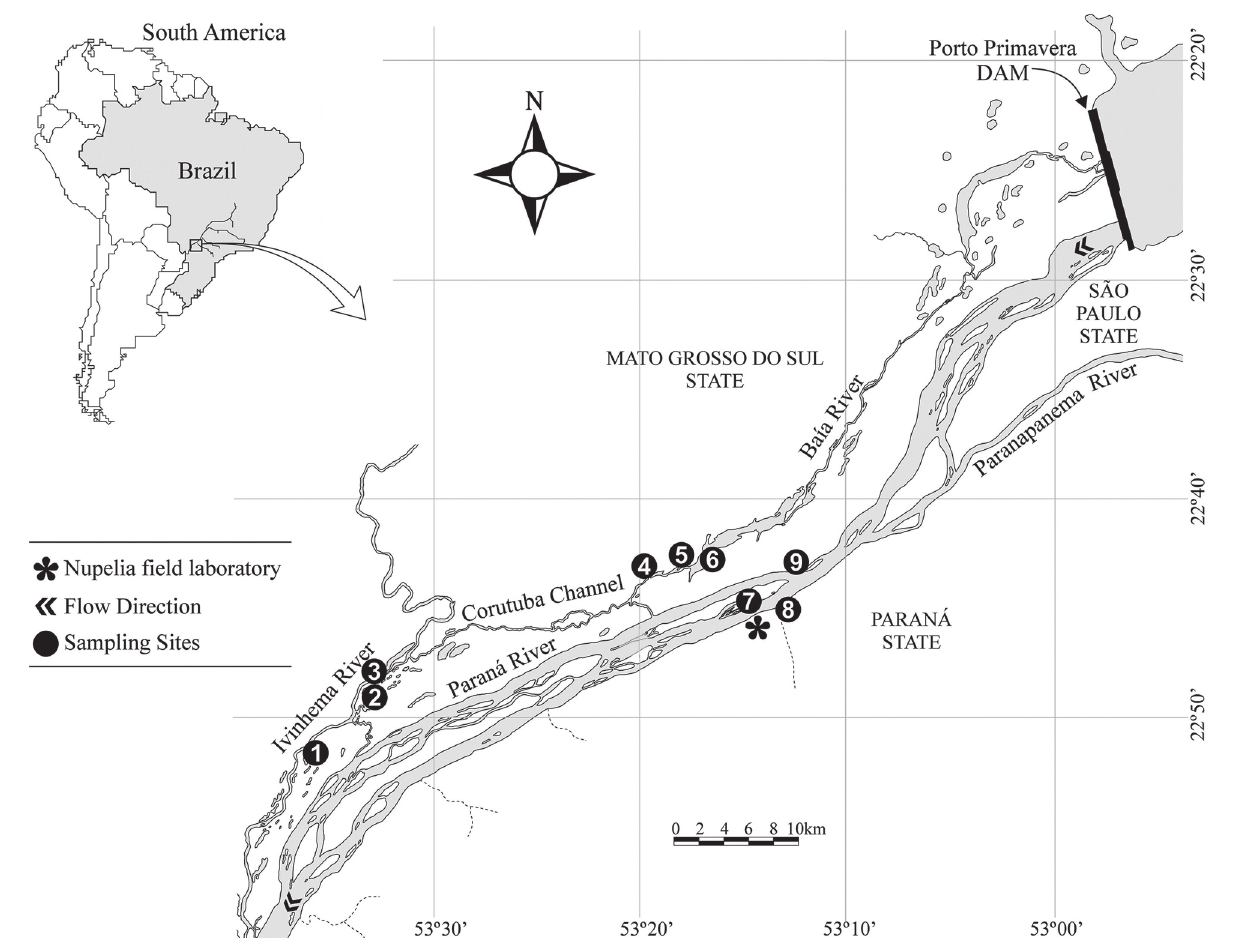
Fig. 1. Sampling sites in the upper Paraná River floodplain. Ivinhema subsystem (1. Ventura Lake, 2. Patos Lake and 3. Ivinhema River), Baía subsystem (4. Guarana Lake, 5. Fechada Lake and 6. Baía River) and Paraná subsystem (7. Pau Veio backwater, 8. Paraná River and 9. Garças